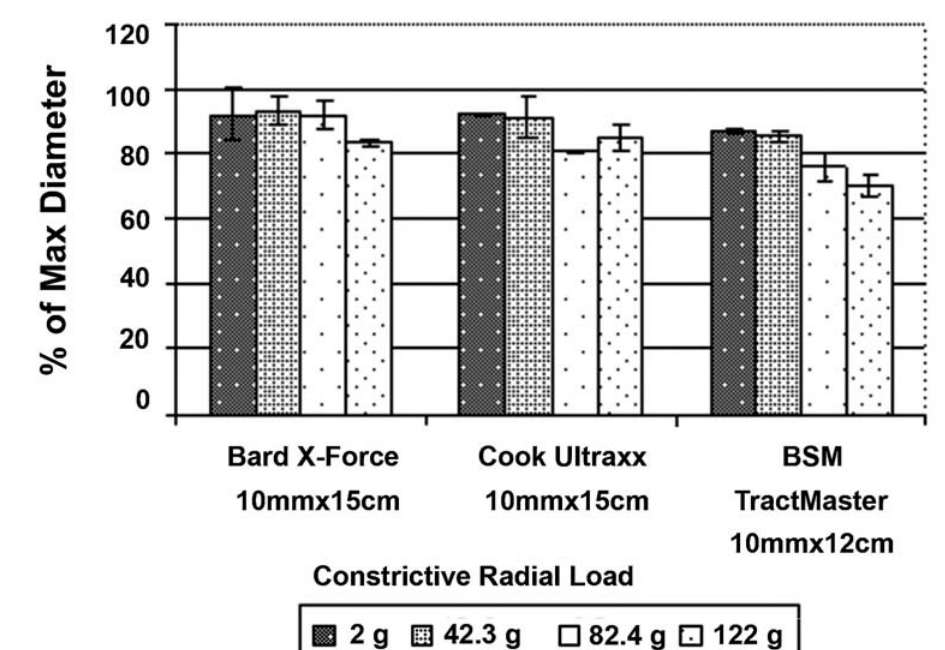
Figure 2 – Balloon dilation at 4